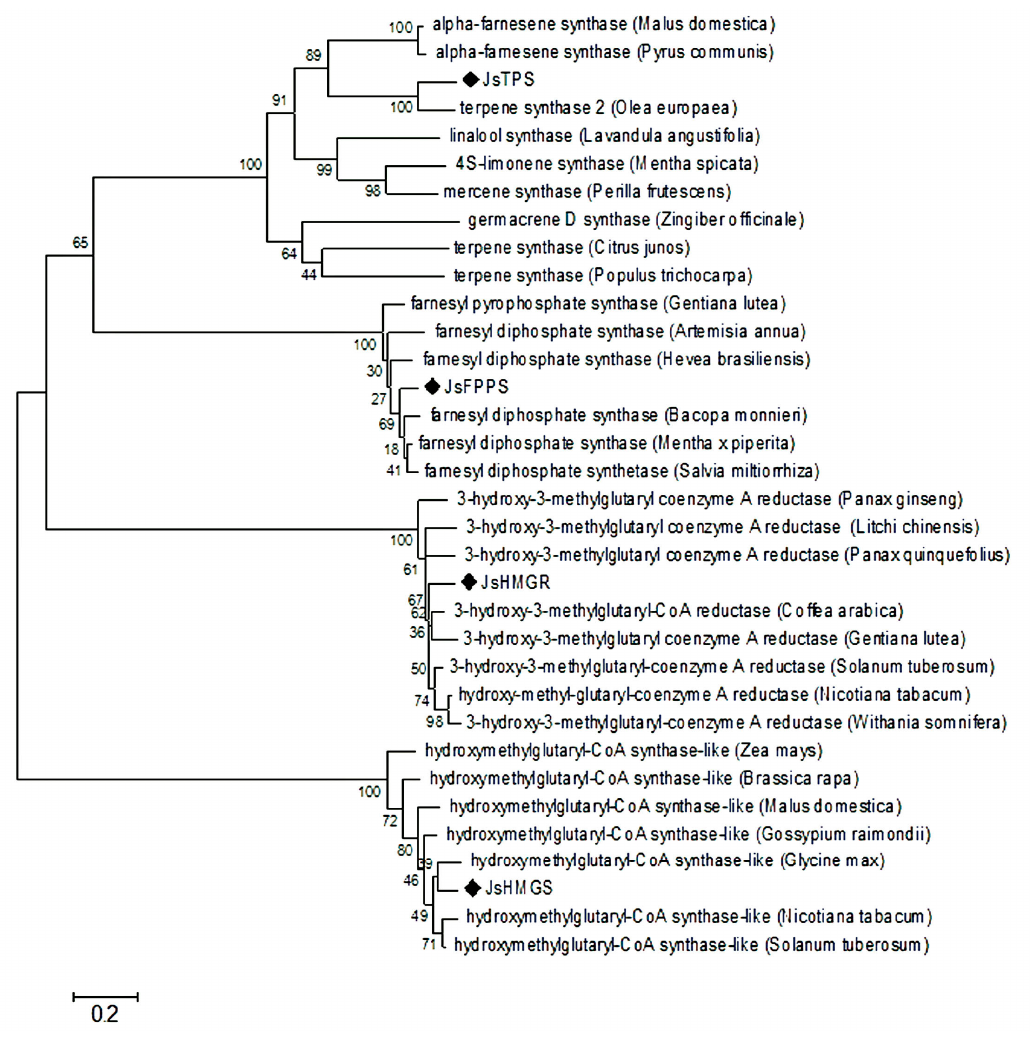
Figure 3. Neighbor-joining phylogenetic tree based on JsHMGS , JsHMGR , JsFPPS , and JsTPS sequence isolated from J. sambac ‘Bifoliatum’ in relation to respective sequences of other plant species derived from GenBank. Numerical values above the branches indicate bootstrap percentiles from 1000 replicates. The scale bar indicates the branch length that corresponds to the number of substitutions per amino acid position.